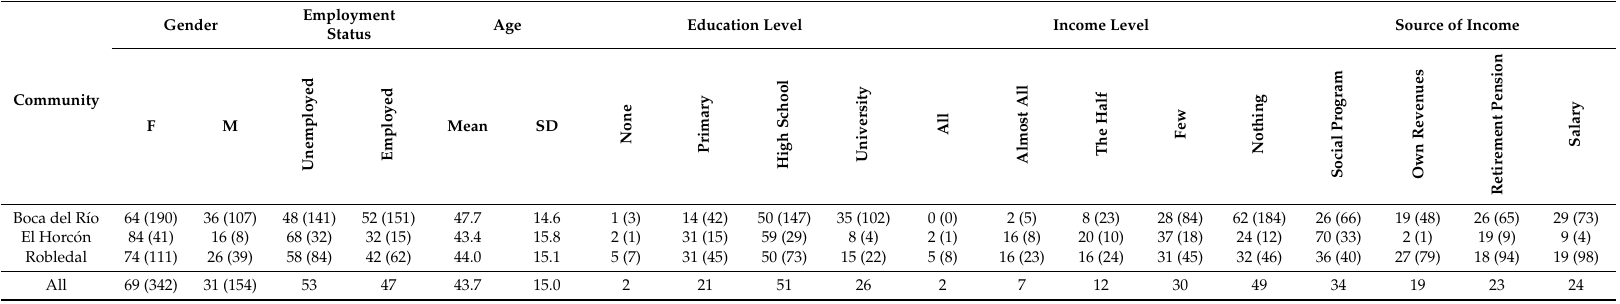
Table 2. Socio-economic characteristics of the three communities surveyed in Macanao Peninsula, Margarita Island, Venezuela. Percentage of people by gender, employment status, educational level, income level, and source of income are shown for each community (number of answers in each category). Also, mean and standard deviation of age by community is